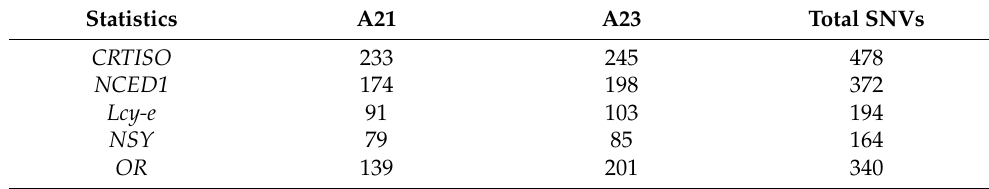
Table 5. Single-nucleotide variations (SNVs) identified in candidate genes of the carotenoids biosynthesis.